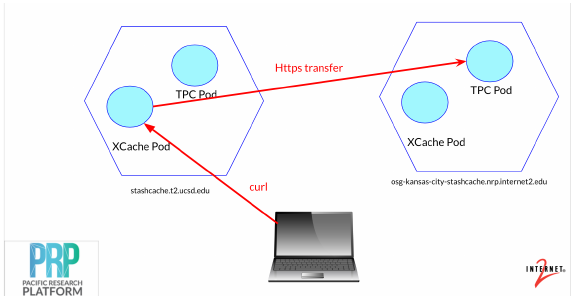
Figure 2. Diagram of TPC transfer tests